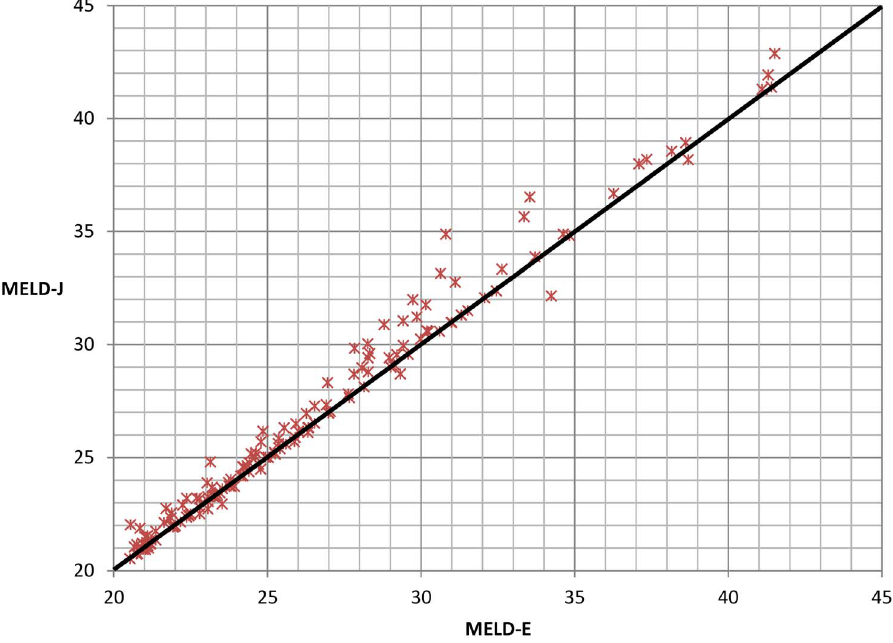
Figure 3. Correlation between MELD-J and MELD-E results for MELD-E scores . 20. For this figure, we did not restrict the MELD scores to a maximum of 40 points, and values were not rounded (r=0.992; p , 0.001).